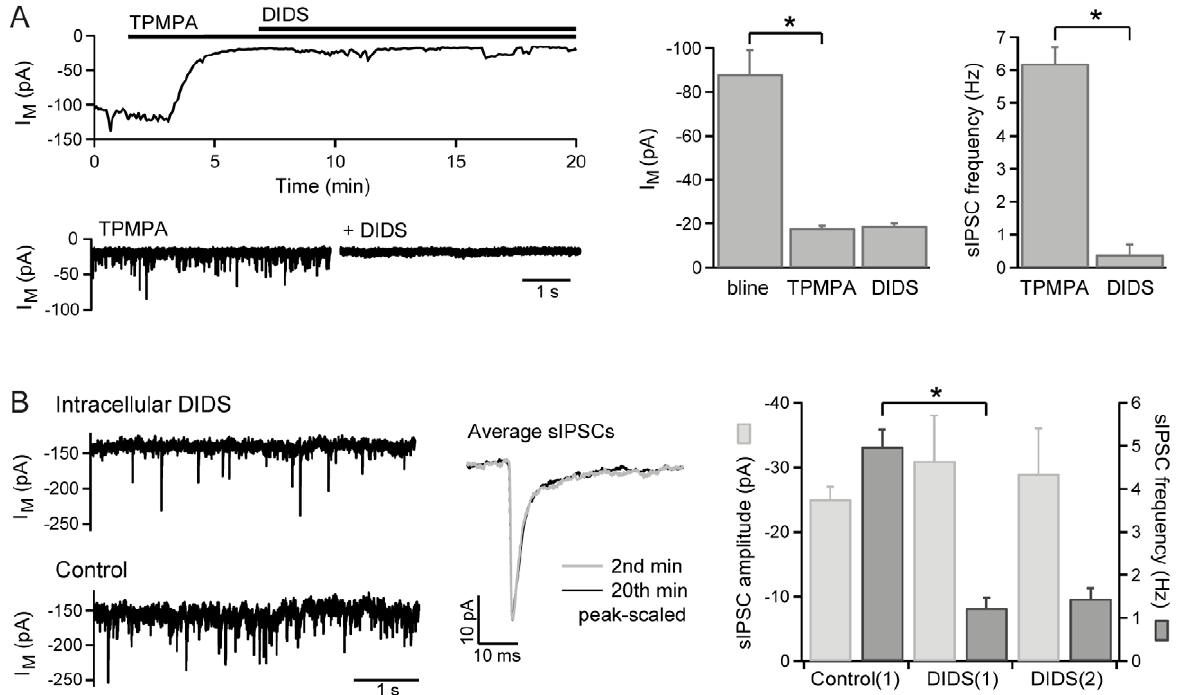
Figure 3. The effect of DIDS on GABA A R currents. A, An example recording and mean data (n=4) showing that application of DIDS (500 m M) in the presence of TPMPA (200 m M) but not bicuculline has no effect on the holding current but inhibits spontaneous GABA A R-mediated IPSCs (sIPSCs). B, Example current traces from recordings with and without DIDS (500 m M) included in the intracellular solution, with average sIPSCs from a different recording with intracellular DIDS (500 m M), and mean sIPSC amplitude and frequency data in control recordings (n=5) and recordings with intracellular DIDS (0.5–1 mM; n=5). Control(1) and DIDS(1) were measured during the 2 nd minute after gaining whole-cell access, DIDS(2) was measured during the 6 th minute.